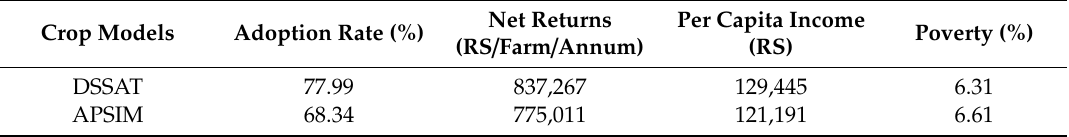
Table 8. Impact of climate change adaptations on the current rice-wheat agricultural production system using DSSAT and